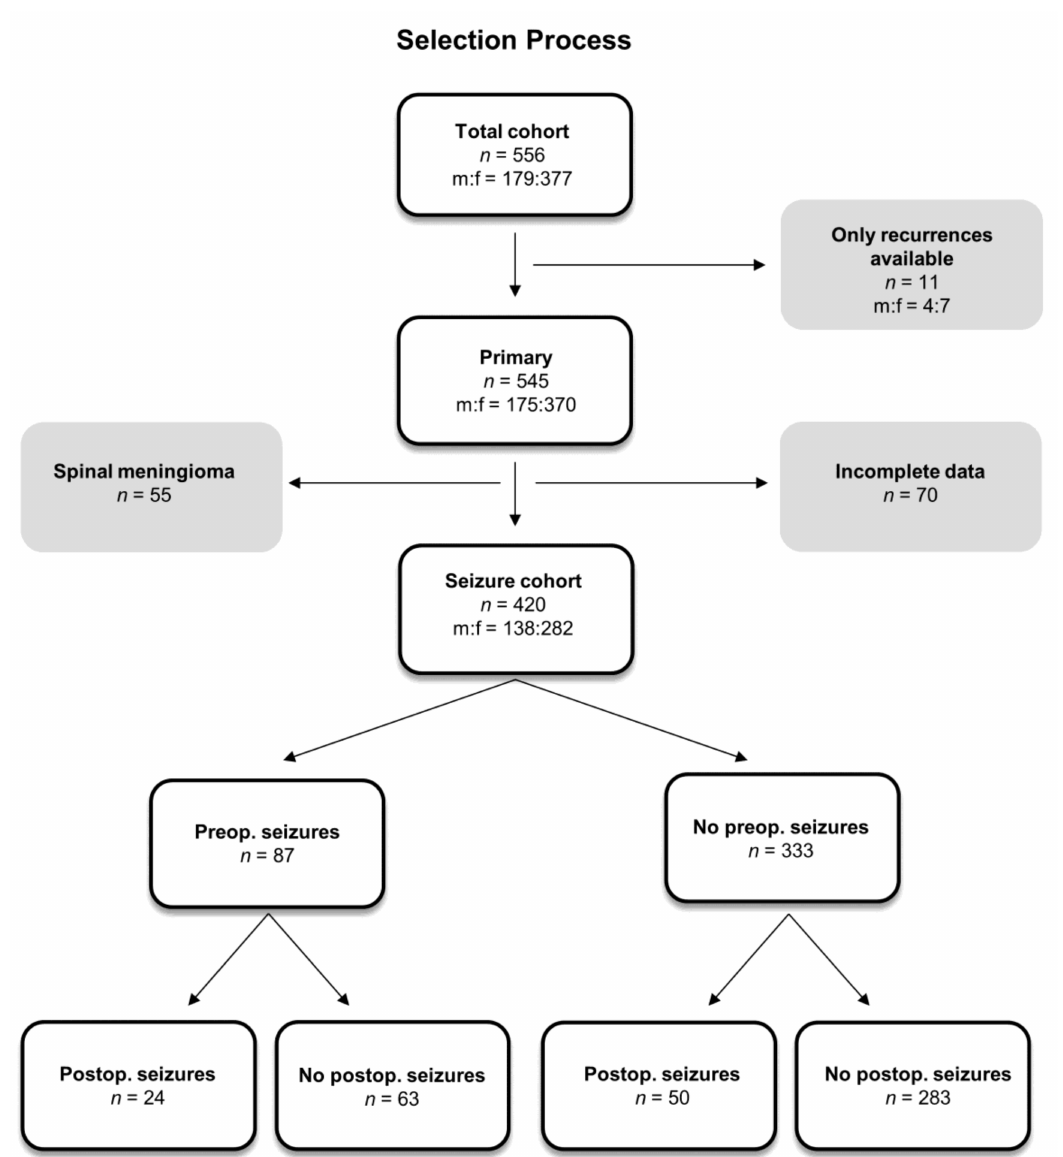
Figure 1. Flow diagram summarizing the selection process and giving an overview of the course of disease for patients with or without preoperative